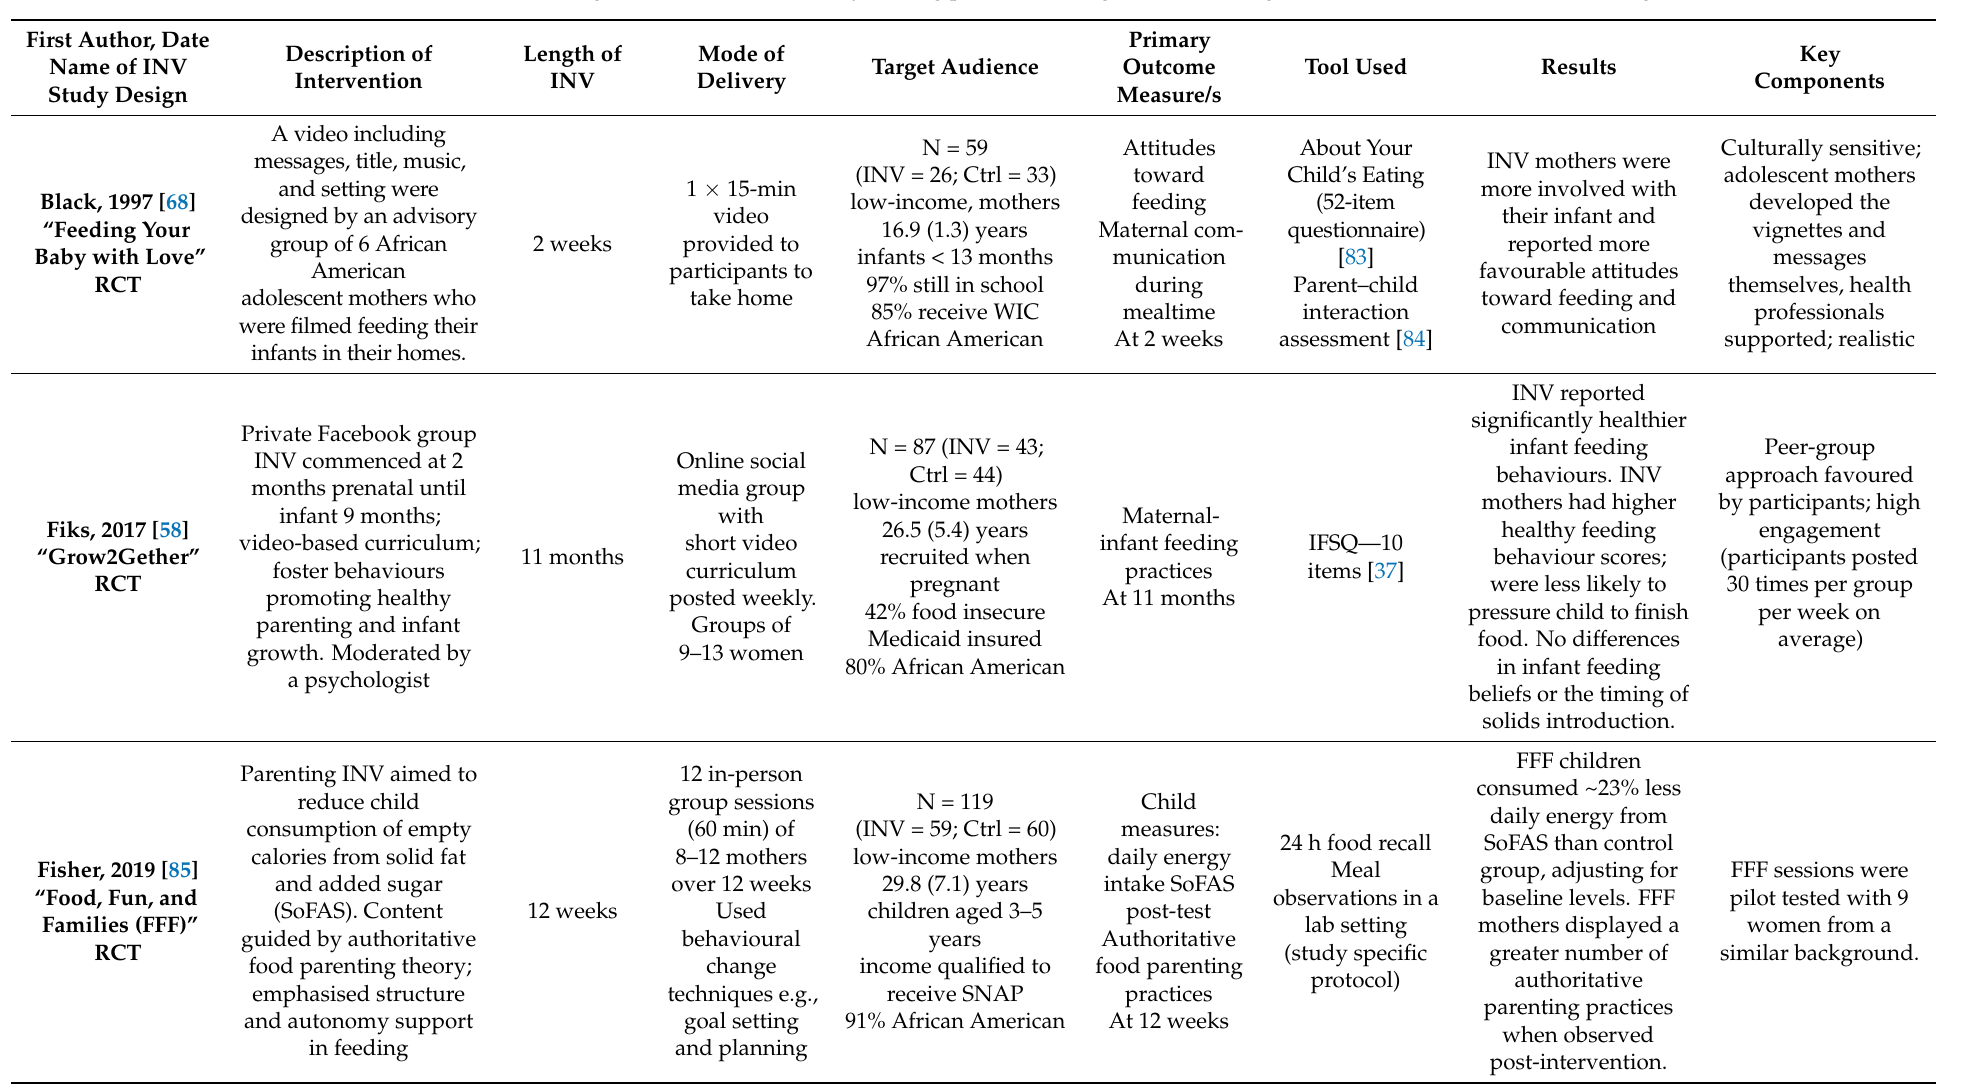
Table 3. Studies describing an intervention to modify feeding practices amongst families living with HFI, low income or disadvantage ( n =